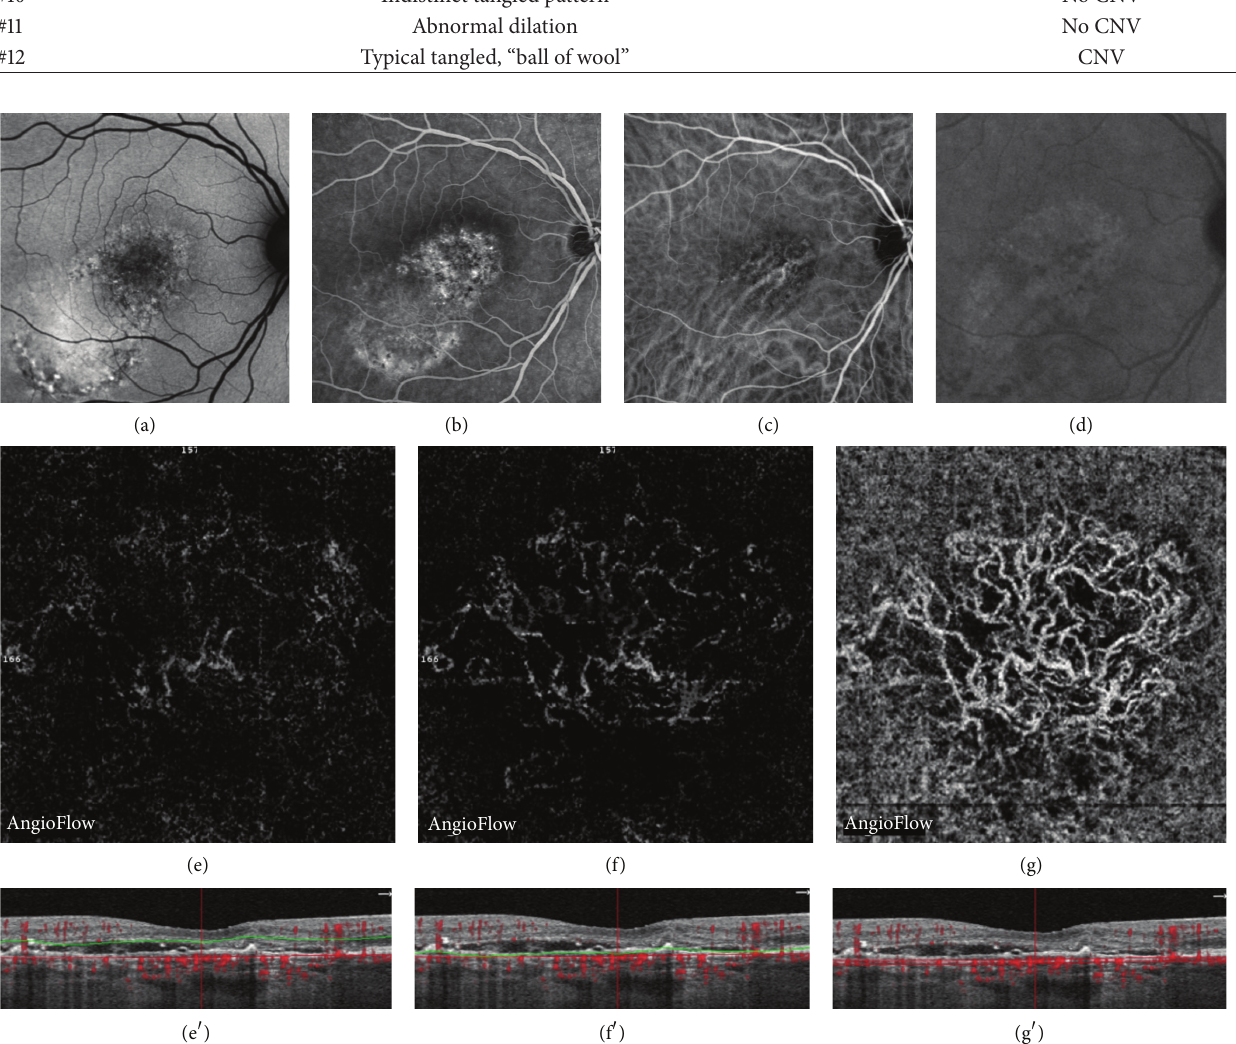
Figure 4: Central serous chorioretinopathy (CSC) complicated by choroidal neovascularization (CNV) in a 59-year-old woman. Multimodal imaging showing the correlation between fundus autofluorescence (FAF (a)), fluorescein angiography (FA (b)), indocyanine green angiography (ICGA(c) and (d)), and OCT angiography (OCTA(e), (f), (g)) with coregistered OCT B-scans showing the level of segmentation (e 󸀠 , f 󸀠 , g 󸀠 ). Chronic CSC with pigmentary changes and areas of hyperautofluorescence, uneven leakage of fluorescein, and dilated choroidal vessels ((a) to (c)) and presence of a choroidal neovascular membrane in the late phase of ICGA (d). Automatically segmented outer retina OCTA,showingaverymoderatehyperdensesignal(e).ManuallysegmentedouterretinaOCTA,detectingahyperdensesignalcorresponding to a discrete blood flow (f). Automatically segmented choriocapillaris OCTA showing a hyperdense signal that highlights a tangled lesion with a typical neovascular